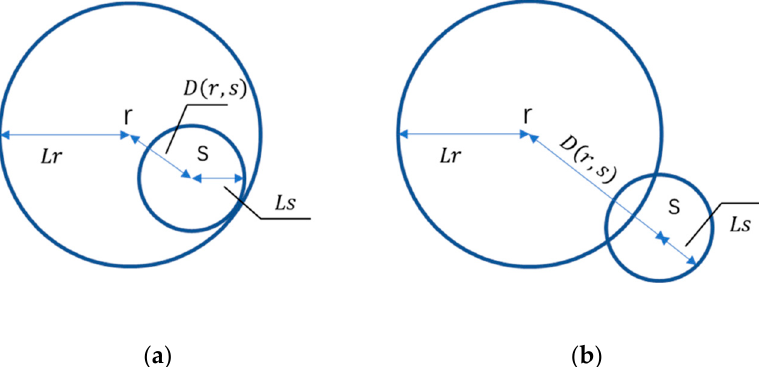
Figure 3. Nested relation inference method. ( a ) Same-tree constraint; ( b ) level constraint. r and s are two different nodes, Lr is the latency guarantee of r , Ls is the latency guarantee of s , D ( r , s ) is the latency between s and r.